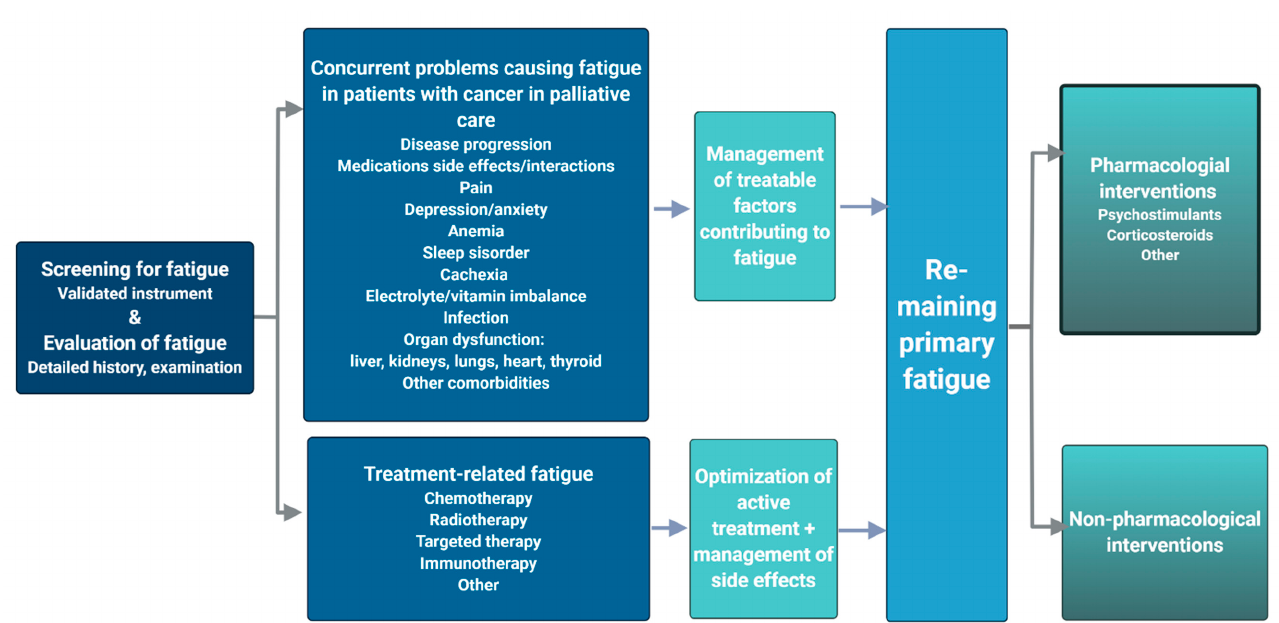
Figure 1. Etiology and management of cancer related fatigue. Made with Biorender.com. Adopted from similar figures in previous work [4,13,23,24].